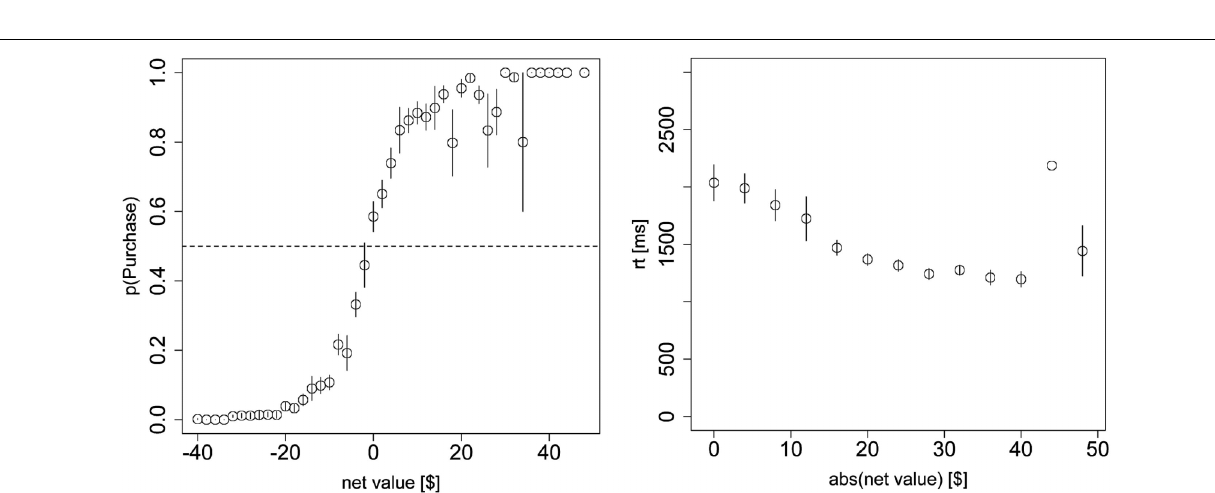
FIGUREA2 | Replication of all the figures from the text but including the $0 products.